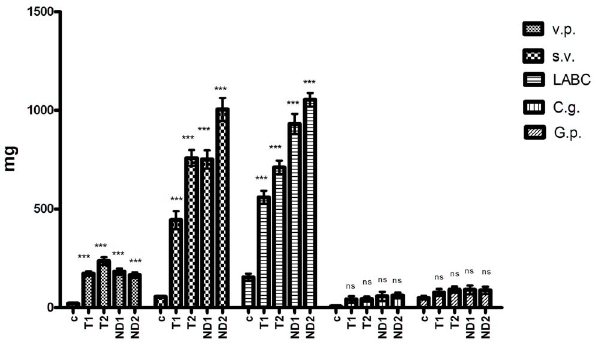
Figure 2. Effects of testosterone and nandrolone decanoate on the weight of accessory sex tissues.